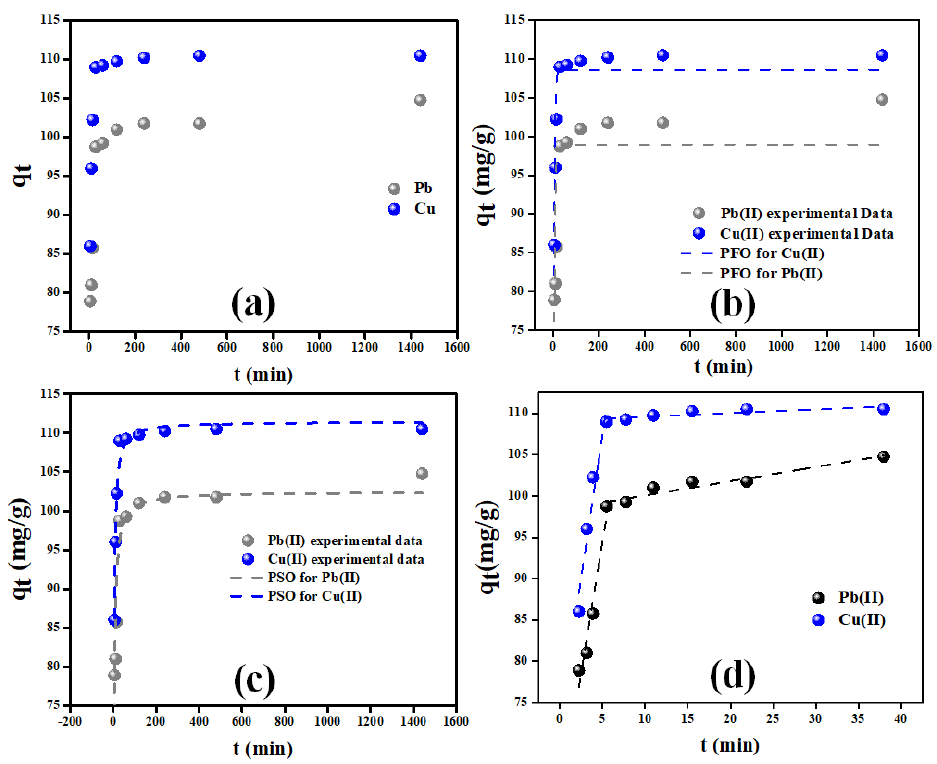
Figure 6. ( a ) Contact time ( b ) PFO, ( c ) PSO, and ( d ) intra–particle-diffusion on the adsorption of Pb 2+ and Cu(II) onto MgO nanorods.